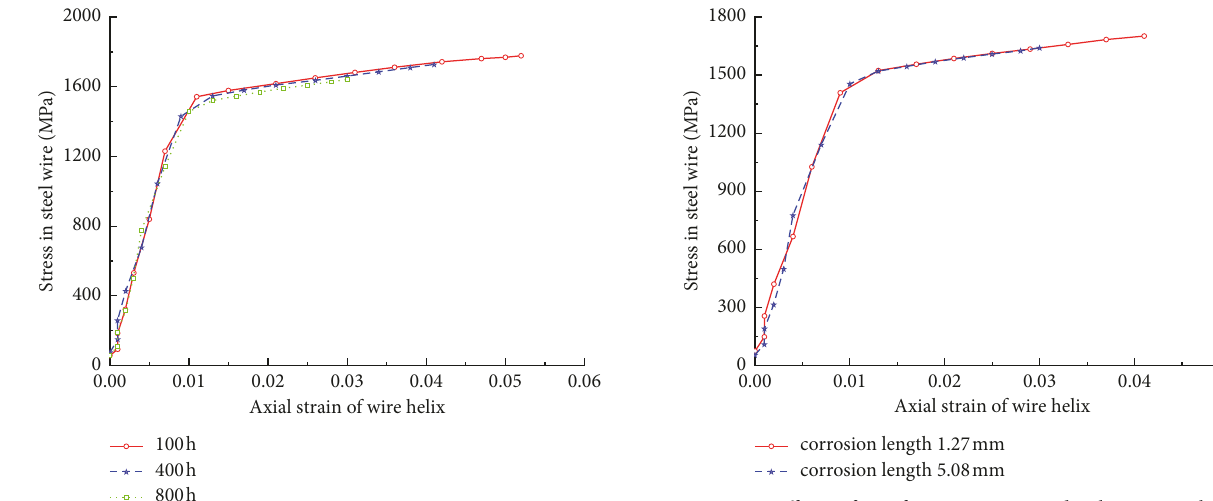
Figure 9: Effect of uniform corrosion depth on mechanical properties of steel wire.